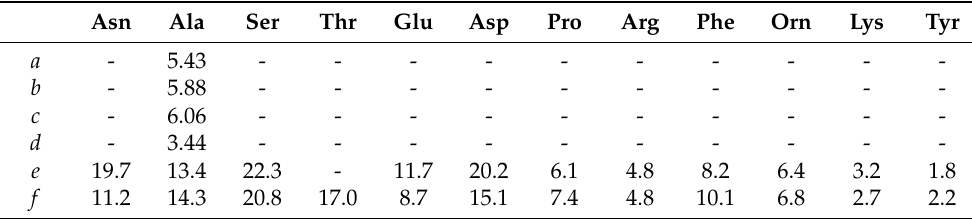
Table 2. Percentages (%) of free D -amino acids relative to the corresponding total amino acid content in commercial garlic foodstuffs a – f